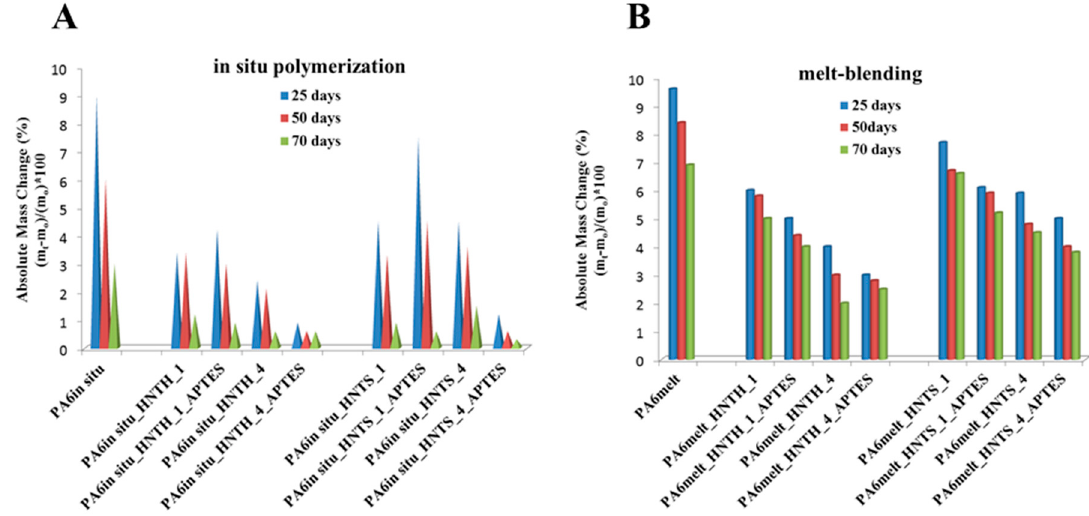
Figure 5. Water absorption in ( A ) PA6 in situ _HNT and ( B ) PA6 melt _HNT nanocomposites.